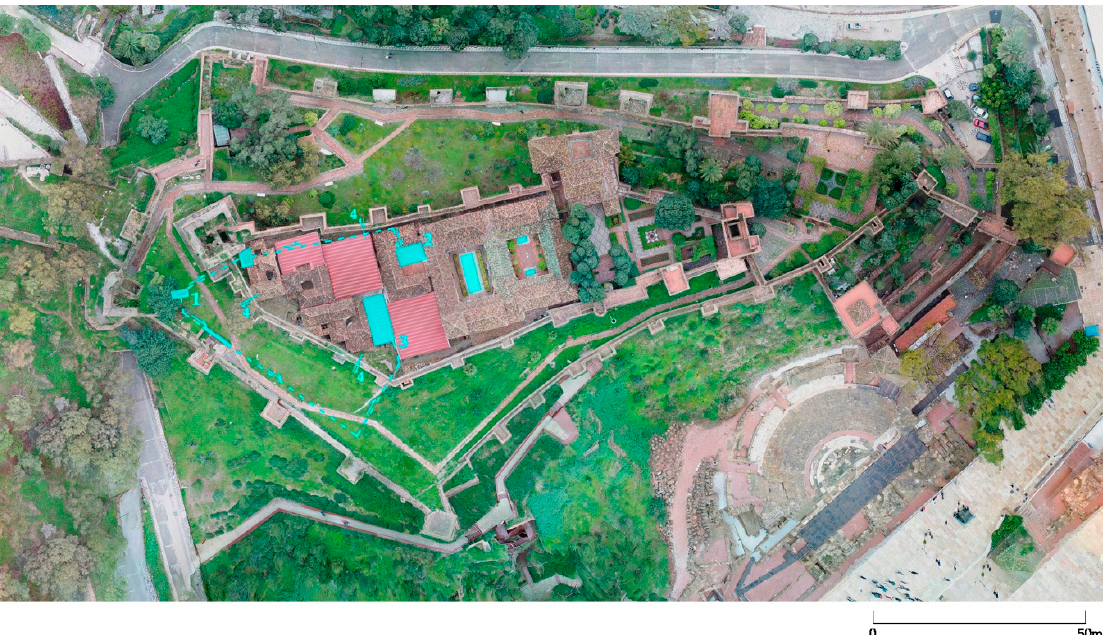
Figure 5. Ortho-corrected photogrammetry of the Alcazaba of Málaga. Hydraulic constructions and